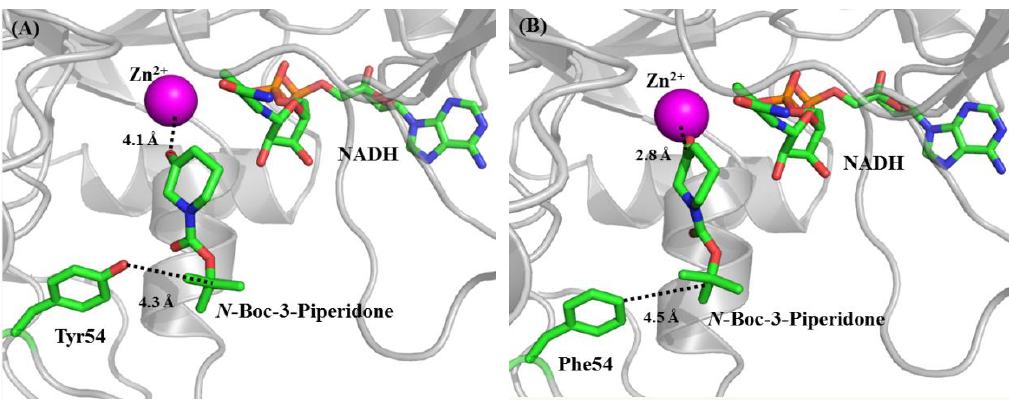
Figure 5. Protein-ligand structures of ReCR with NBPO ( A ) and ReCR Y54F with NBPO ( B ). ReCR and ReCR Y54F are represented in cartoon format. Tyr54, Phe54, NADH, and NBPO are highlighted in sticks. The zinc ion is shown as a magenta sphere.